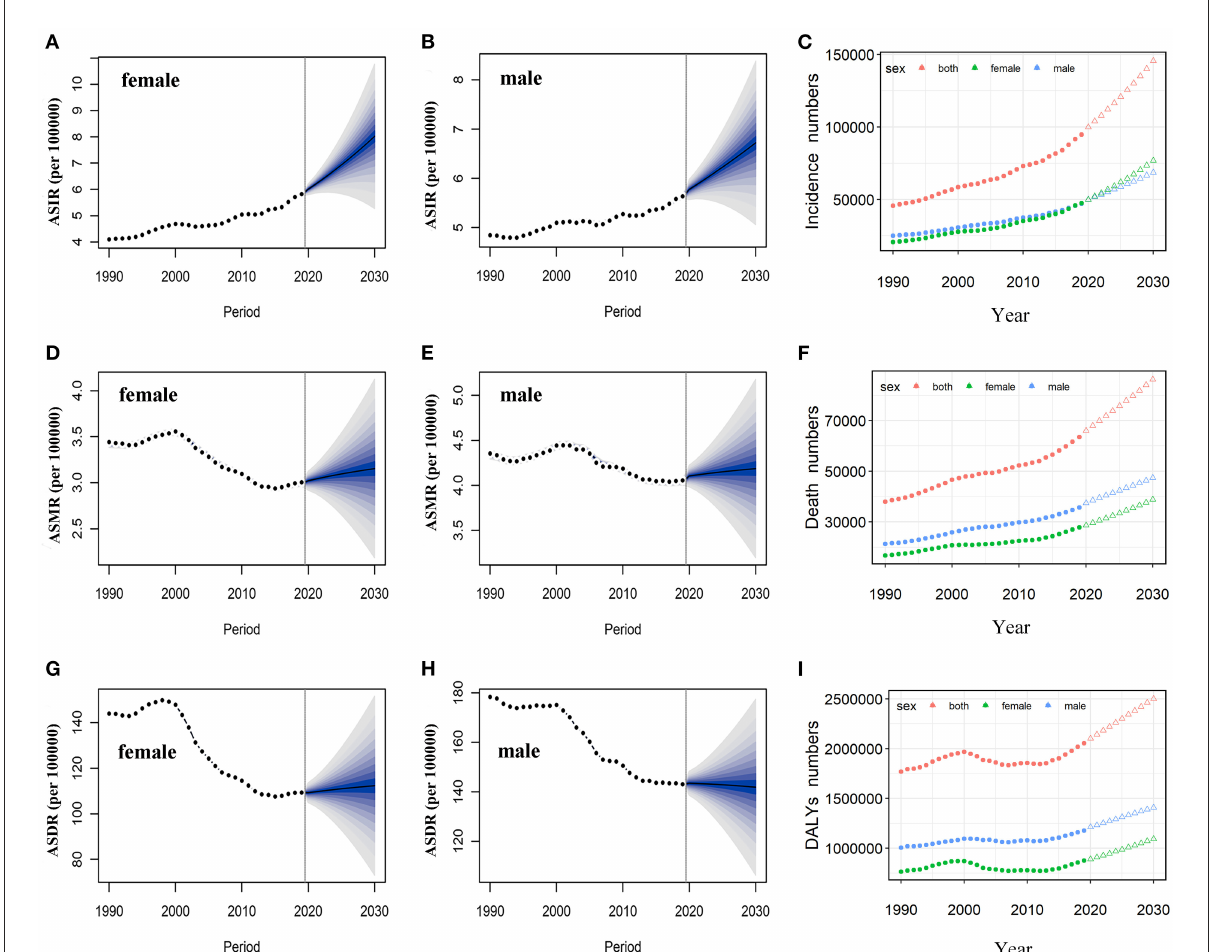
FIGURE6 Temporal trends and projected ASIR, ASMR, and ASDR by sex, from 1990 to 2030 in China. Projected temporal trends in ASIR for Chinese women (A) and men (B) from 1990 to 2030. Projected temporal trends in ASMR for Chinese women (D) and men (E) from 1990 to 2030. Projected temporal trends in ASDR for Chinese women (G) and men (H) from 1990 to 2030. Projected numbers of incidences (C) , deaths (F) , and DALYs (I) from 1990 to 2030 in China. Observed (dashed lines) and predicted rates (solid lines). The fan shows the predictive distribution between the 5 and 95% quantiles. Observed (solid circle) and predicted numbers (triangle). DALYs, disability-adjusted life years; CNS, central nervous system; ASIR, age-standardized incidence rate; ASMR, age-standardized mortality rate; ASDR, age-standardized disability-adjusted life years